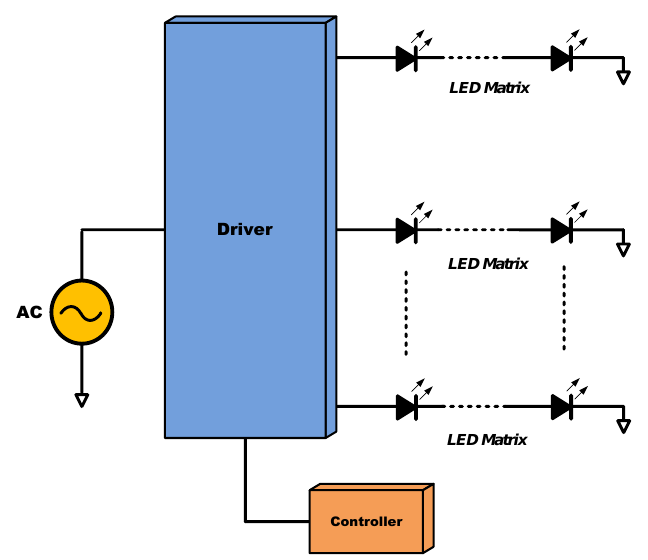
Figure 18. Block Diagram of LED illumination systems.